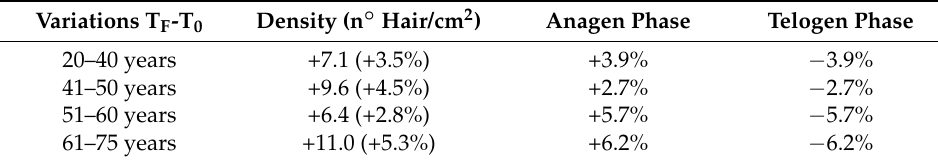
Table 1. Improvements (T F -T 0 ) of hair density and percentage of hair in anagen/telogen phase at the end of different anti-hair loss cosmetic treatments (lotions, shampoo or diet supplements) as a function of age.